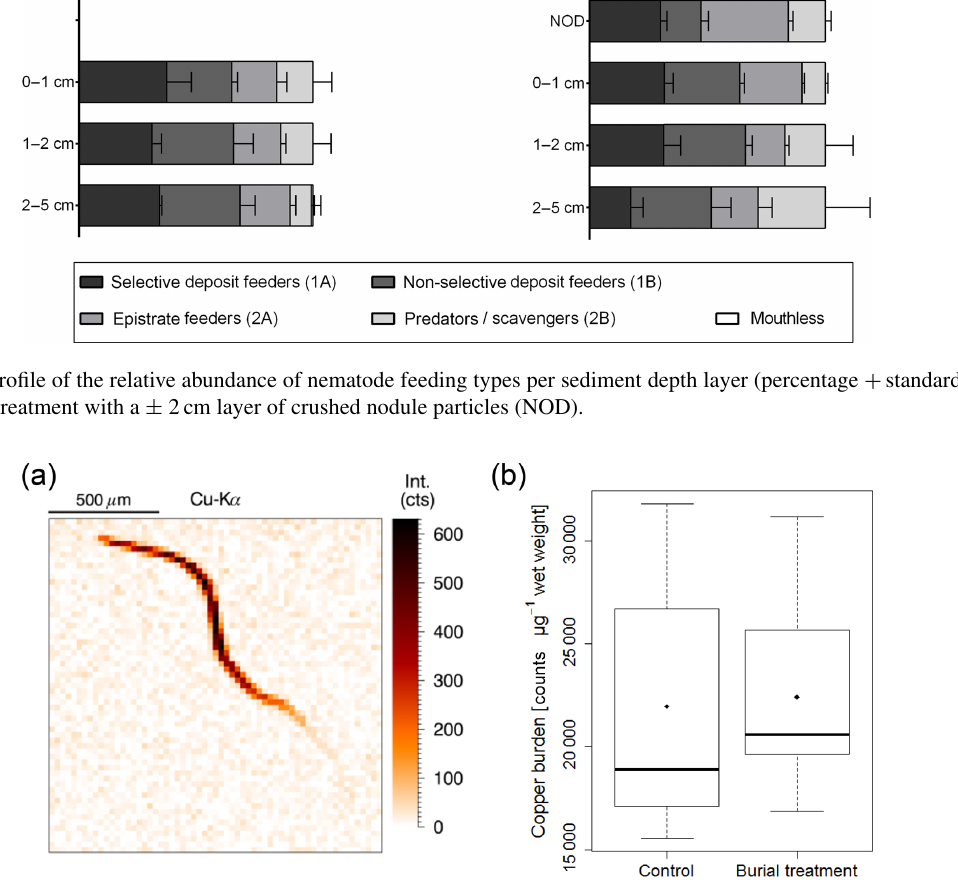
Figure 8. (a) Example image of the copper spectrum from a nematode X-ray mapping indicating copper intensity (counts), which is directly correlated to copper concentration. (b) Box and whisker plot of the copper burden in nematodes from surface sediment layers of a background sample ( n = 11) and from the crushed nodule material of the Burial treatment ( n = 6). Black lines depict the median, whereas dots indicate the mean of the